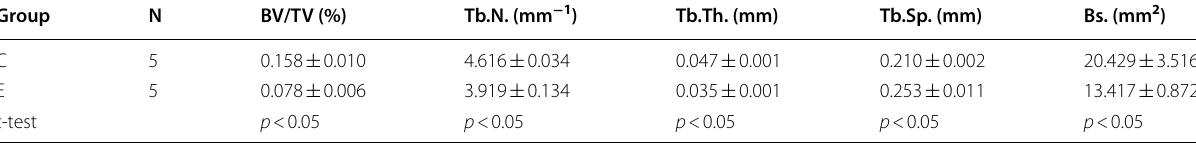
Table 3 Data of quantitative 3D analysis of trabecular bone tissue in mice from both